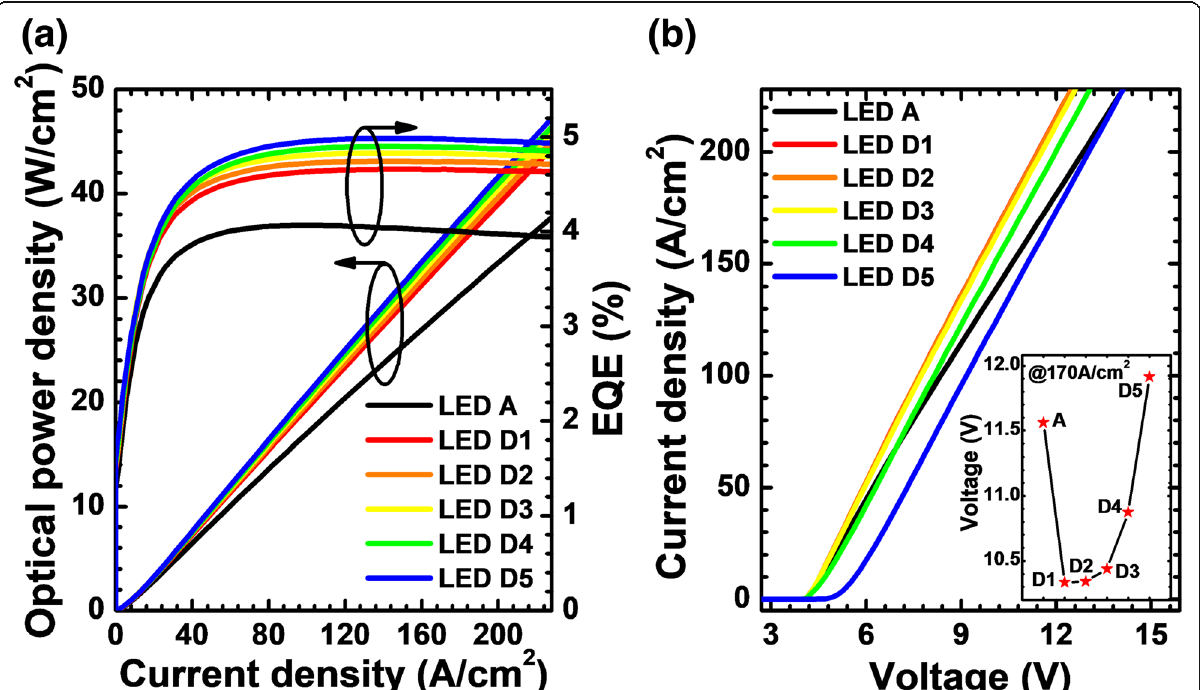
Fig. 10 a EQE and optical power density in terms of the injection current and b current-voltage characteristics for LEDs A and D i ( i = 1, 2, 3, 4, and 5). Inset: the forward voltages for LEDs A and D i ( i = 1, 2, 3, 4, and 5) when the current density is 170 A/cm